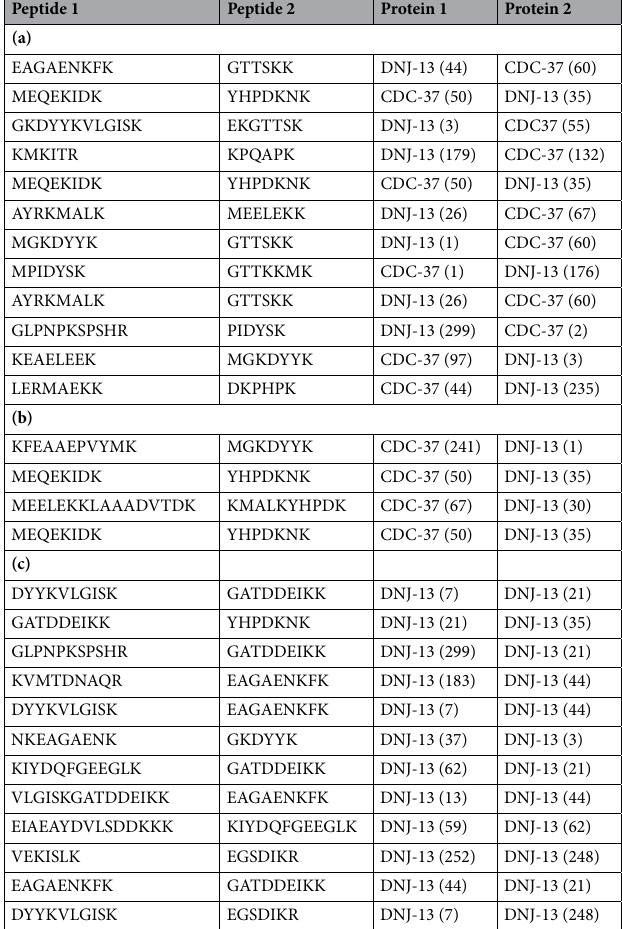
Table 1. Most prominent unique hits in the crosslinked sample. Grey colored parts are obtained from DSSG crosslinked samples while white parts are obtained from BS3 crosslinked samples. a) Intermolecular crosslink pairs of sample #4 (Complex at approx. 135 kDa). b) Intermolecular crosslink pairs of sample #5 (Complex > 245 kDa). c) Both Inter- and intramolecular crosslinked pairs in the reference sample #3 (DNJ-13 dimer).